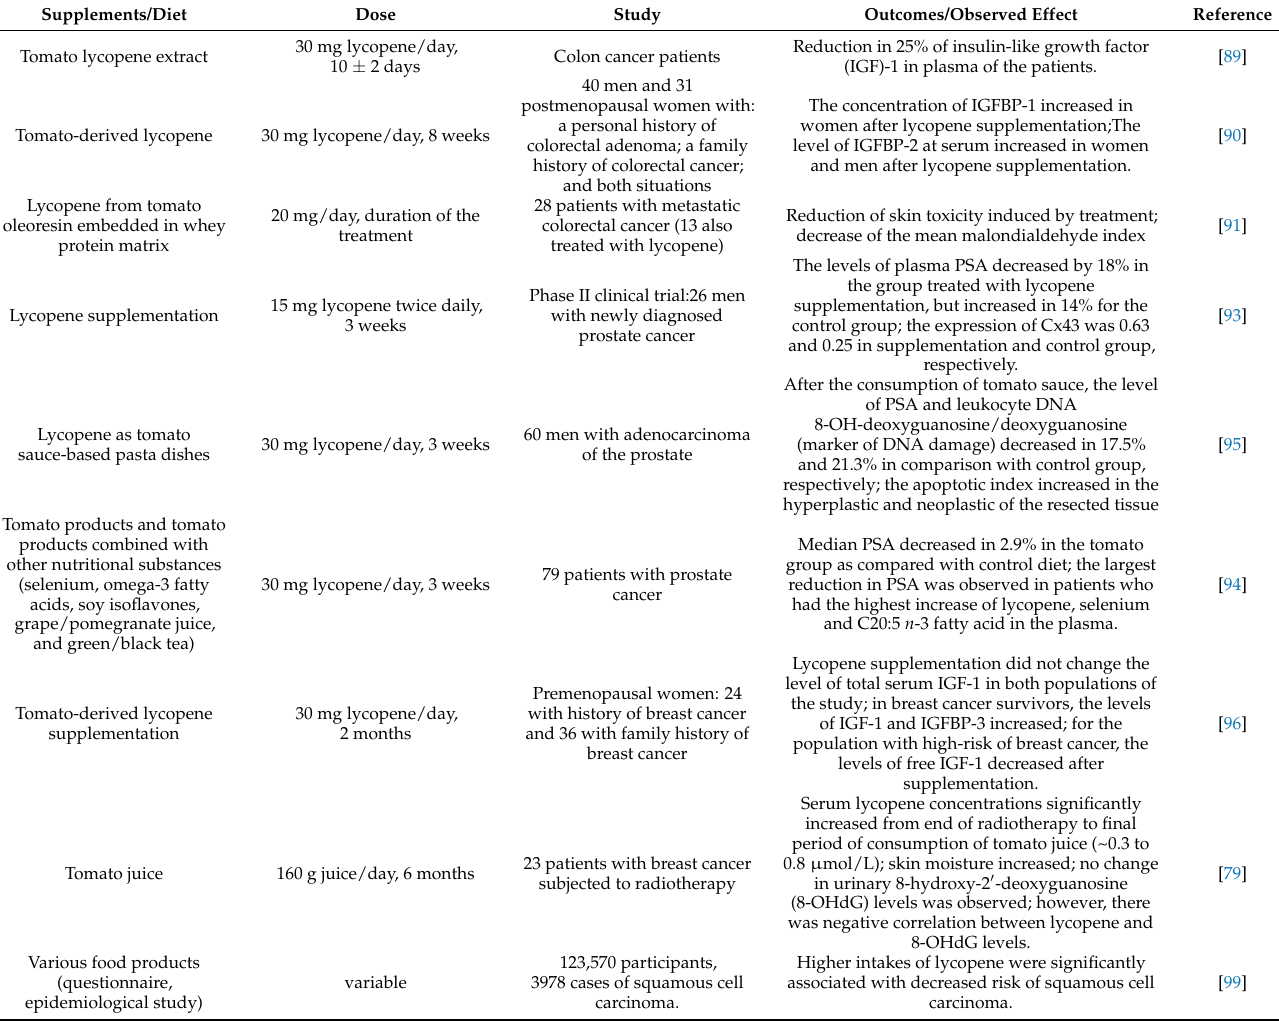
Table 3. Clinical studies to assess the anti-cancer properties of